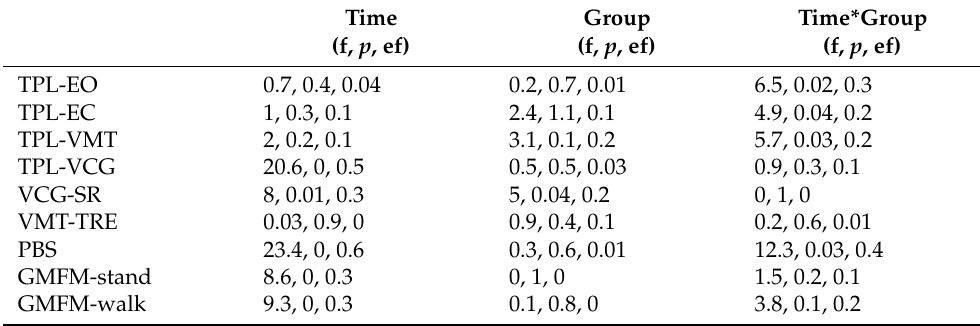
Table 6. Presented ANOVA results are f-statistic (f), p -value ( p ), and effect size (ef) for each outcome measure. All conditions, eyes open (EO), eyes closed (EC), VCG, and VMT, were performed while standing on a